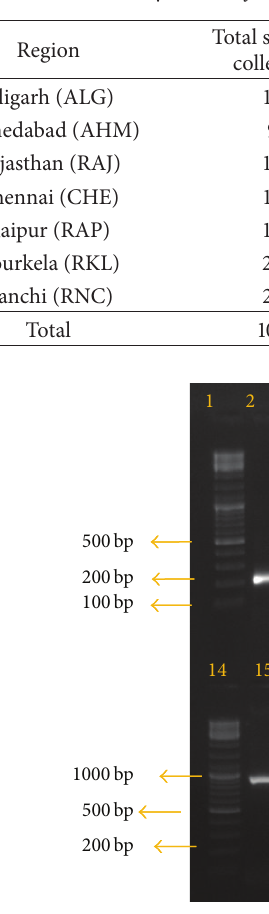
Figure 2: Gel picture showing the amplification of P. falciparum msp1 , msp2 , and glurp genes. Lane 2 shows msp1 allelic family K1, lanes 3 and 4 show allelic family MAD20, lanes 5 and 6 show allelic family RO33, lanes 7 and 8 show msp2 allelic family FC27, lanes 9, 10, and 11 show family IC3D7, lanes 15, 16, and 17 show glurp gene amplification, lane 13 is the negative control, and lanes 1, 12, 14, and 18 show 100 bp DNA